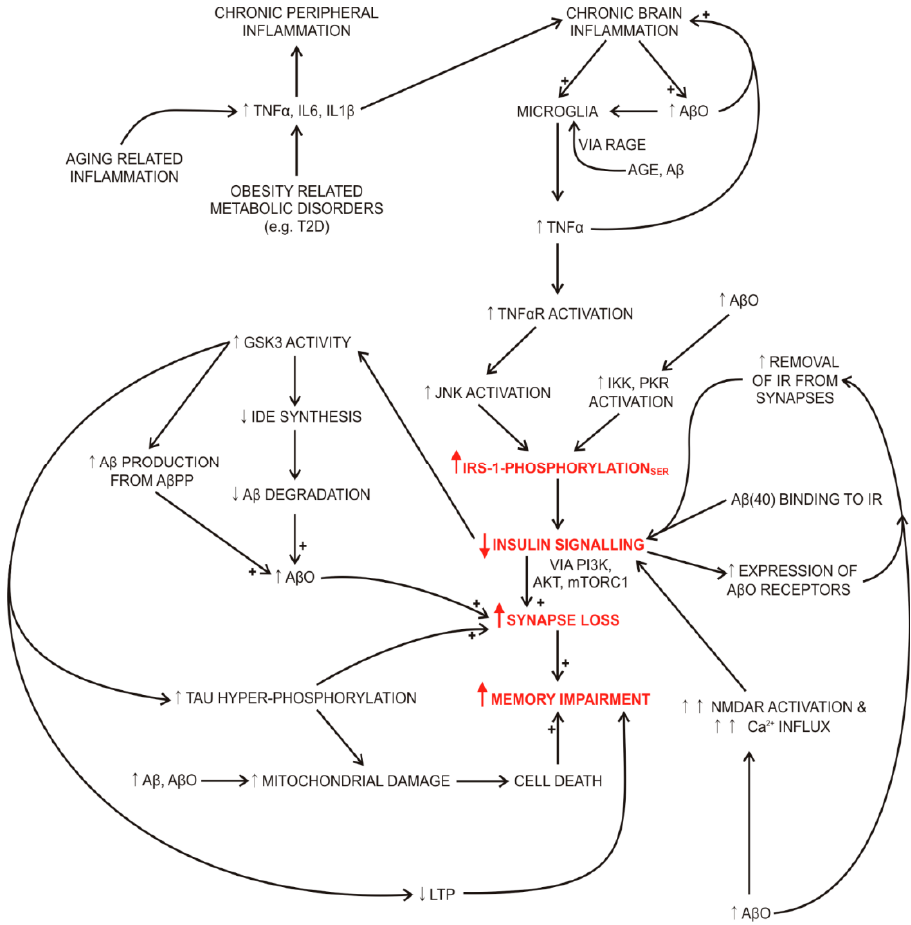
Figure 1. Interactions between AD and T2D signalling pathways in the brain. Abbreviations: A β (amyloid β peptide); A β O (toxic, soluble oligomer); A β PP (amyloid β precursor protein); AGE (advanced glycation end product); AKT (protein kinase B); GSK3 (glycogen synthase kinase 3); IDE (insulin degrading enzyme); IKK (I κ B α kinase); IL1 β (interleukin 1 β ); IL6 (interleukin 6); IR (insulin receptor); IRS-1 (insulin receptor substrate 1); JNK (c-Jun N-terminal kinase); LTP (long-term potentiation); mTORC1 (mammalian target of rapamycin complex 1); NMDAR ( N -methyl- D -aspartate receptor); PI3K (phosphoinositide 3-kinase); PKR (double-stranded RNA-dependent protein kinase); RAGE (receptor for advanced glycation end products); SER (serine residue of IRS-1); T2D (type 2 diabetes); TNF α (tumour necrosis factor α ); TNF α R (tumour necrosis factor α receptor).